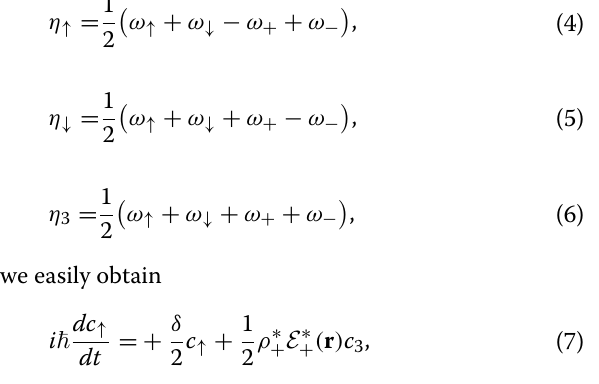
are the electric fields experienced by atoms, where denote the unit vectors of the polarization direction of light, ω are the angular frequencies of Raman beams, ± E ( r ) are the spatial complex amplitudes. The wave and ± function of atoms can also be written in the bare hyper- fine basis as